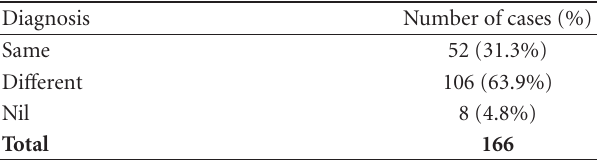
Table 2: Comparison of diagnosis between antemortem and postmortem reports.